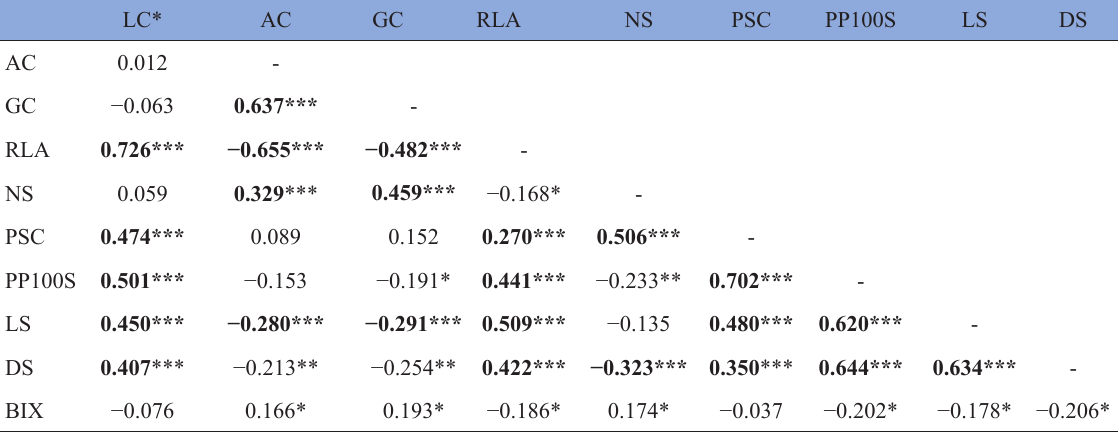
Table 6. Pearson correlation coefficient matrix of the quantitative descriptors used to characterize 149 achiote accessions.